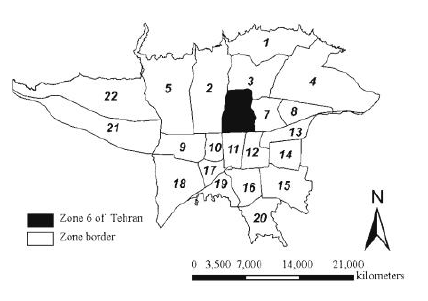
Fig 1. The location of zone# 6 in Tehran